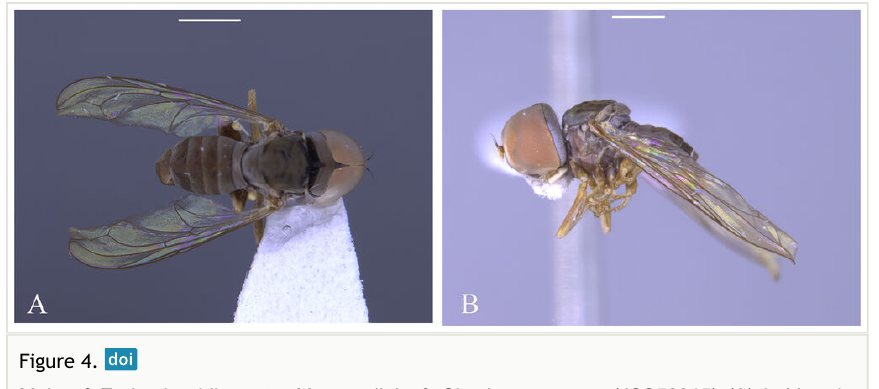
projection at outer side (Fig. 5A); phallic guide strong and straight with two laterally hook-like projections shortly before the apex (Fig. 5C).